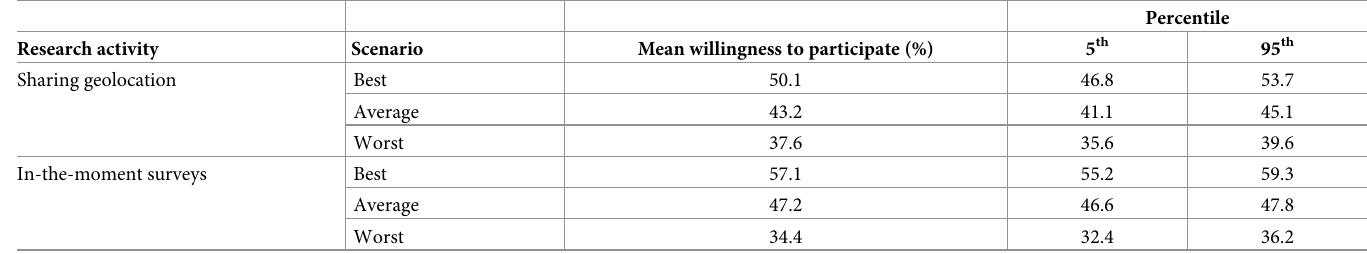
Table 3. Expected willingness to